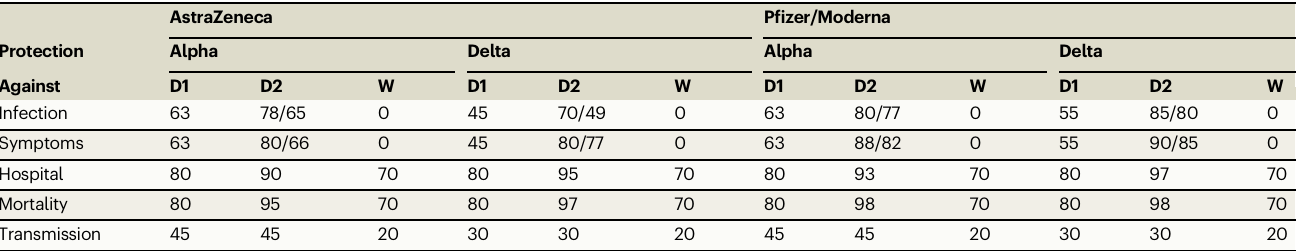
Table 2 | Assumed percentage protection from the two vaccine types against the Alpha and Delta variants after one dose (D1), after two doses (D2, shown for the dose interval gaps of 12-weeks/3-weeks), and after waning